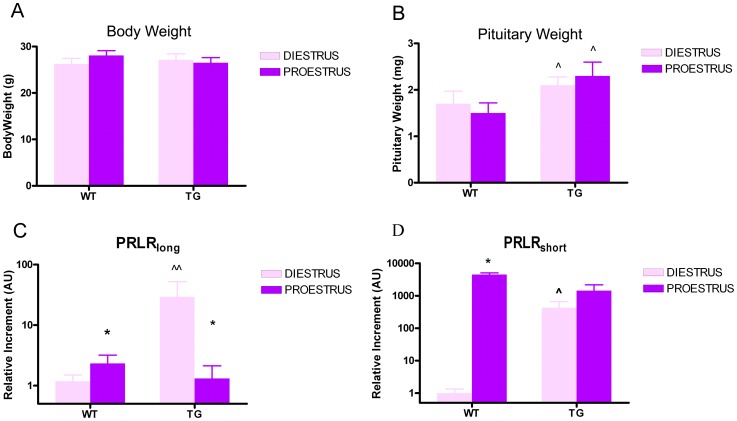
PRLR antagonism increases the expression of the long and short isoforms of PRLR.A, B: Body weight and pituitary weight of WT and TGΔ1–9-G129R-hPRL mice, euthanized at diestrus or proestrus ∧p<0.05 vs. respective WT at diestrus or proestrus. Two-way ANOVA followed by Tukey's test. C, D: Expression of PRLR isoforms in the anterior pituitary from WT and TGΔ1–9-G129R-hPRL mice, euthanized at diestrus or proestrus. Real Time PCR was performed using specific primers for long and short (S1, S2, S3) PRLR isoforms. The S1 short isoform was not detected. Each column represents the relative increment ± SEM with respect to the expression of PRLRlong (C) or PRLRshort (D) in control animals (WT mice at diestrus) (n≥5 animals/group). *p<0.05 vs. respective diestrus, ∧p<0.0.5 and ∧∧p<0.01 vs. respective WT at diestrus. Two-way ANOVA, followed by Tukey's test.